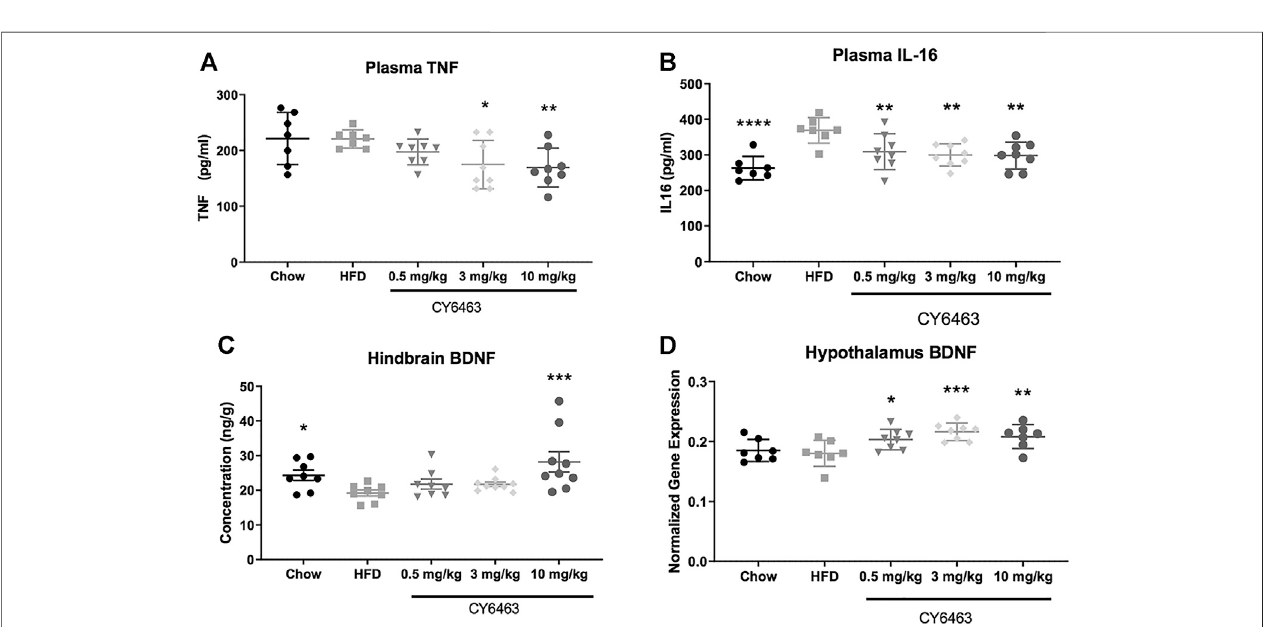
FIGURE 7 | Effect of 6 weeks of treatment with CY6463 in diet-induced obese mice. (A) , plasma TNF α ; (B) , plasma IL-16; (C) , hindbrain BDNF protein concentration; (D) , hypothalamic BNDF gene expression. Data were analyzed compared to HFD control mice using a one-way ANOVA followed by a Fisher ’ s LSD